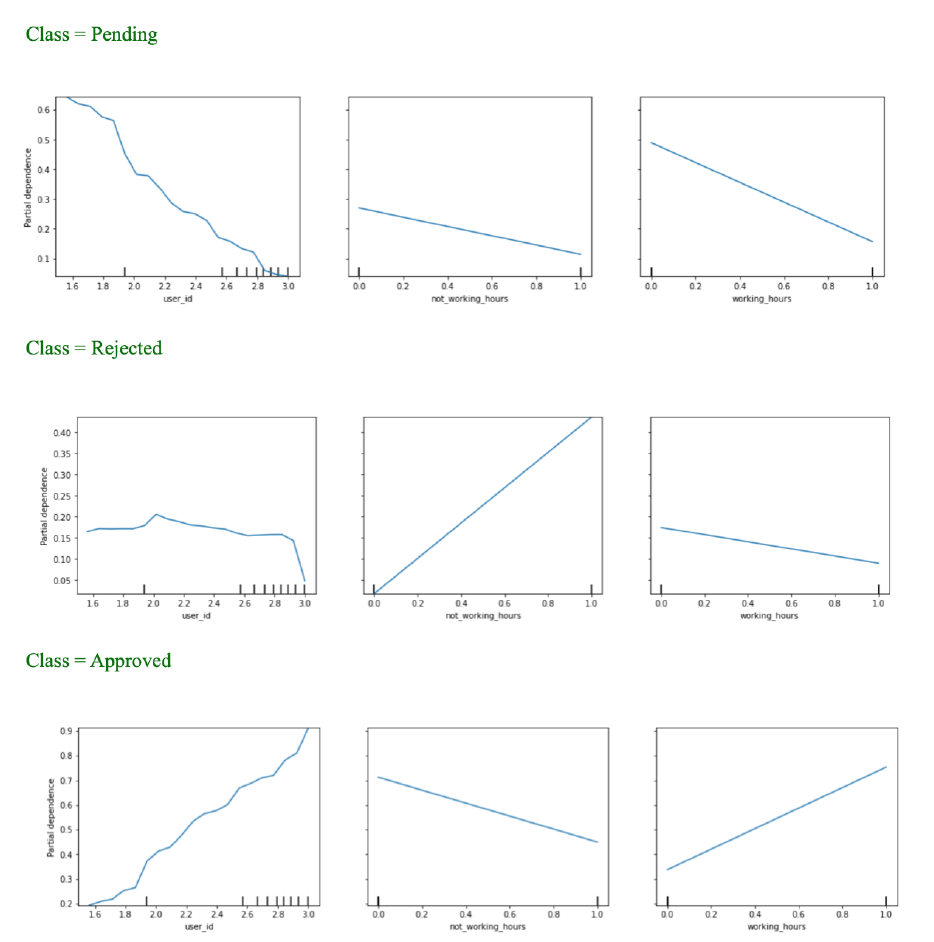
Figure 13. Variable importance for the optimal